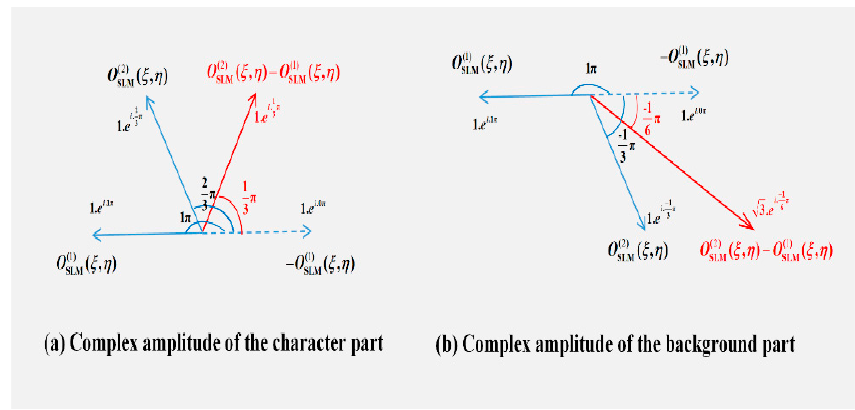
( 1 ) ( ξ , η ) and SLM √ 3 and